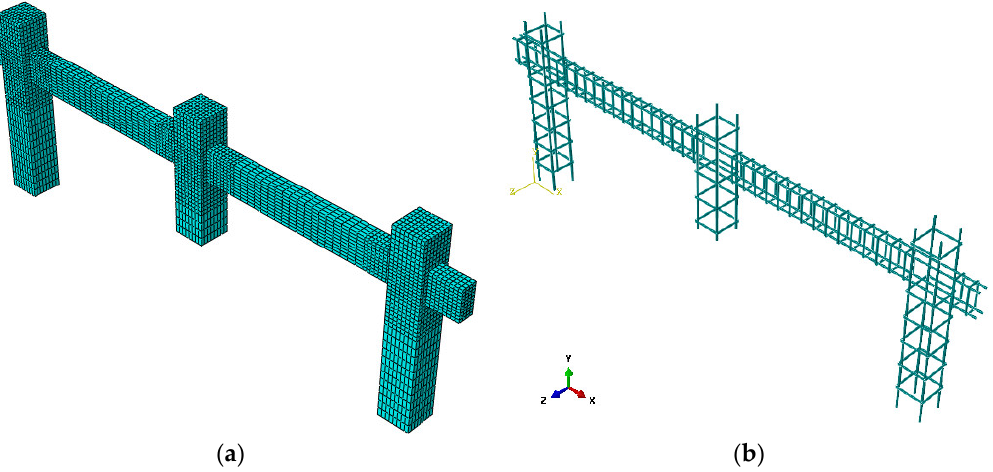
Figure 10. Modelling of all frames in ABAQUS software: ( a ) element meshing and ( b ) reinforcing rebars.